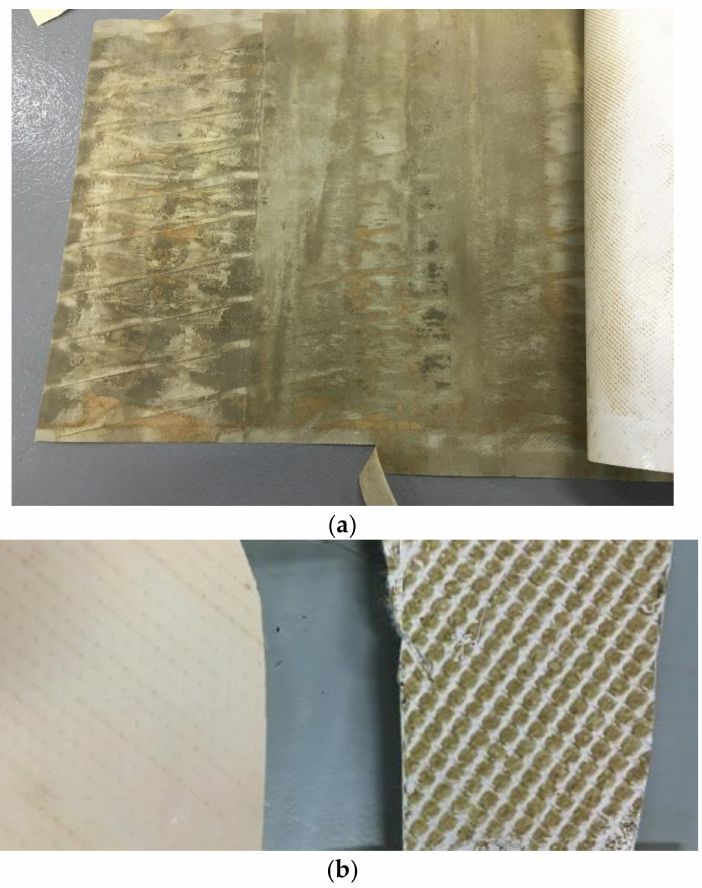
Figure 8. Illustration of the fouling that occurred for the RO membrane. ( a ) Fouled backing layer; ( b ) virgin membrane surface [left] vs. post trial membrane surface